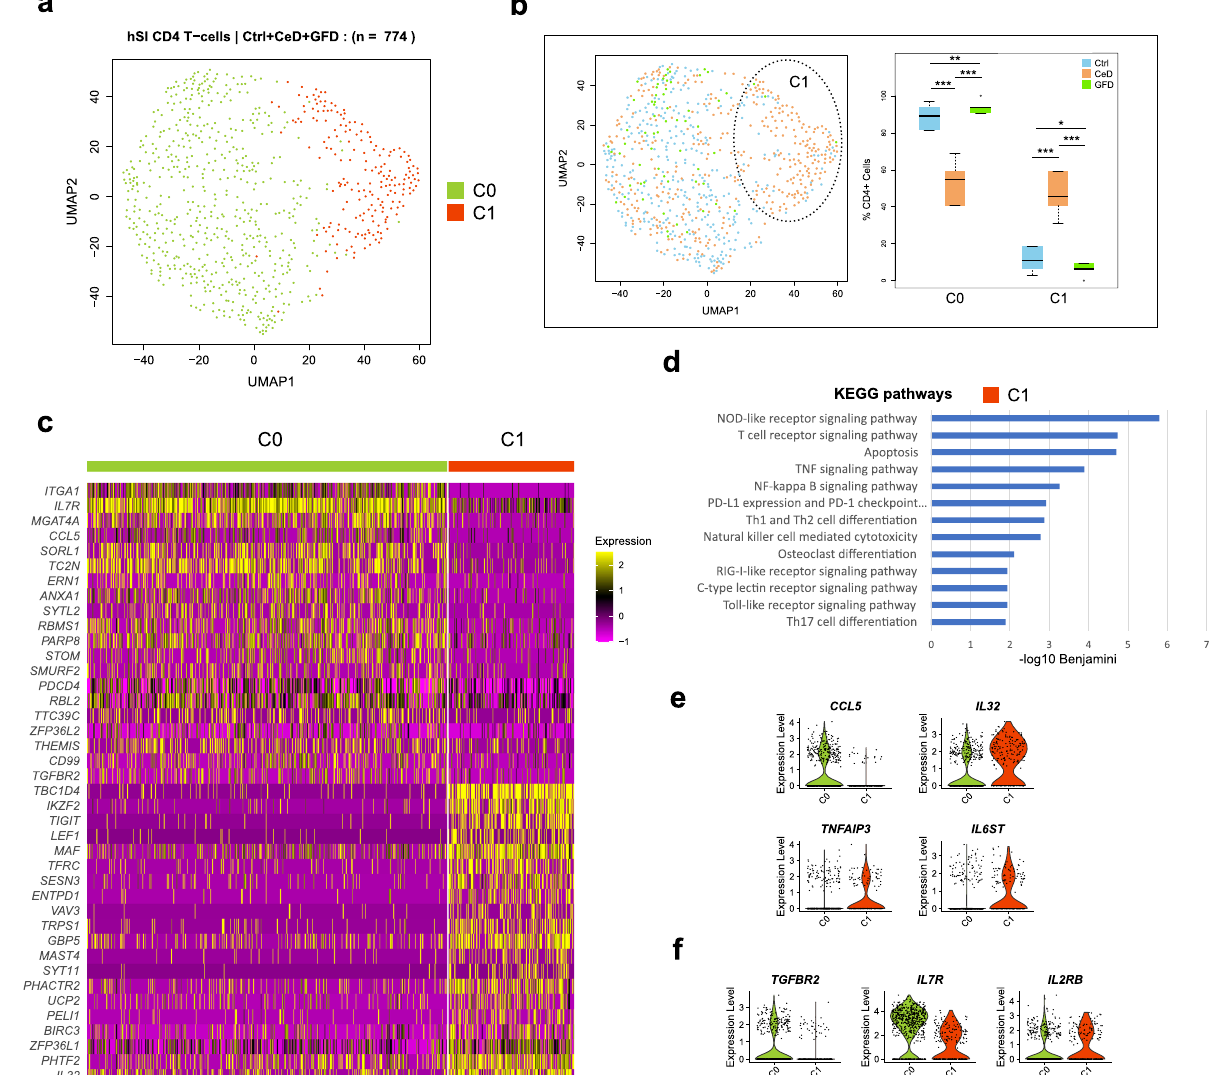
Fig. 4 | Single-cell landscape of CD4 + T cells in Lamina Propria of human small intestine in Ctrl, CeD and GFD samples. a UMAP clustering scatter plot of CD4 + T cells in Lamina Propria (LP) of Ctrl (control subjects), CeD (Celiac disease patients)andGFD(Celiacpatientsongluten-freediet)samples b ProjectionofCtrl, CeD and GFD derived cells on the UMAP clusters (left scatter plot) and the per- centage of cells across the clusters per each condition as compared to each other (right boxplots) (center line, median; box limits, upper and lower quartiles; whis- kers,minimumandmaximumvalues;points,outliers,1.5xinterquartilerange;two- sidedt-test p value<=0.05(C0:CtrlvsCeD=4.38×10 − 9 ,CtrlvsGFD=0.0038,CeD